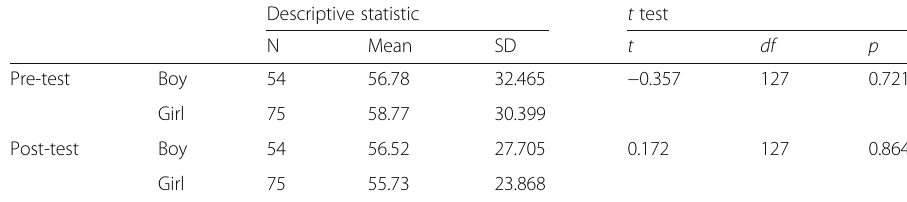
Table 10 Independent t test result for students ’ academic achievements (gender difference analysis)